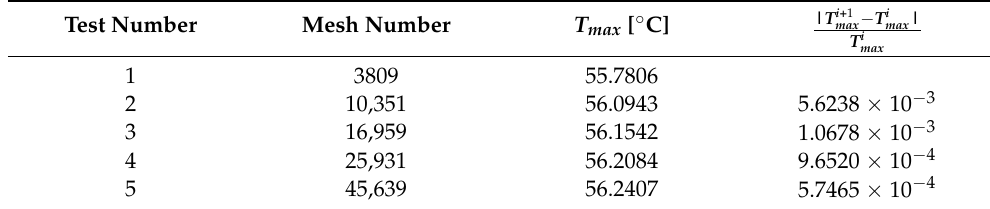
Table 6. The mesh independence test.